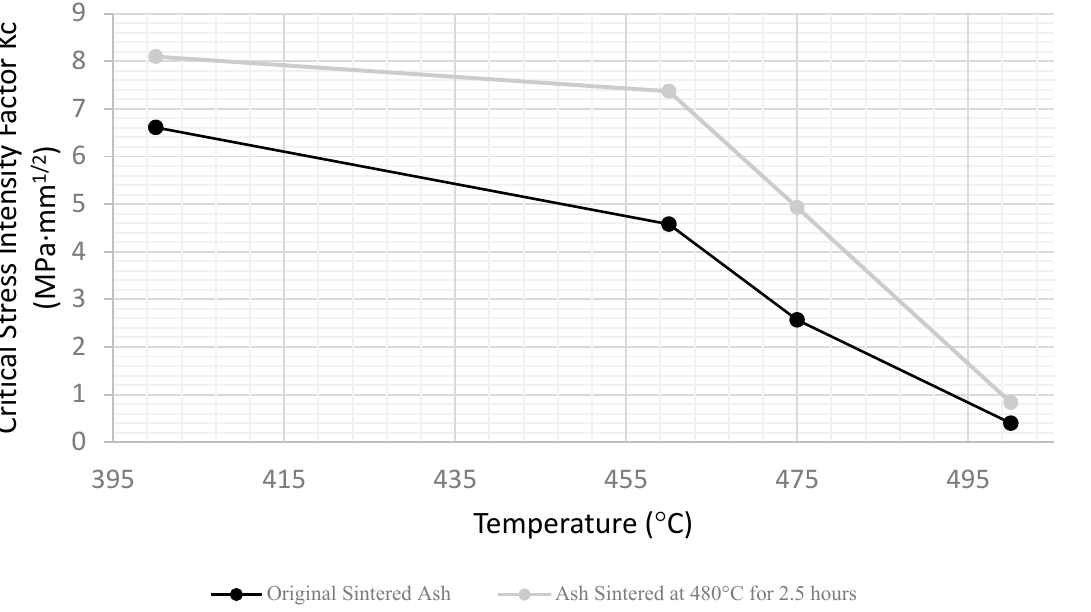
Figure 12. Critical stress intensity factor versus temperature for original sintered ash and extended sintered ash.